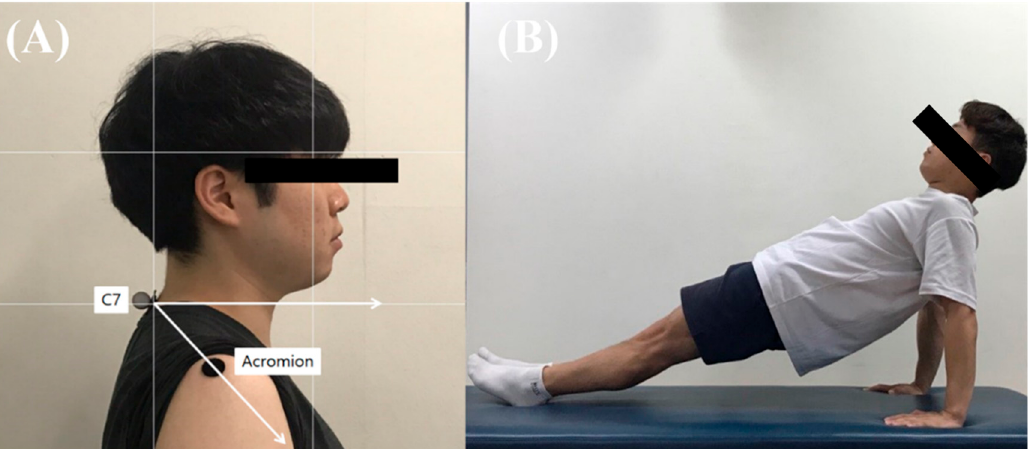
Figure 1. ( A ) Adhesive marker placement and postural angles ( B ) Reverse plank exercise position.